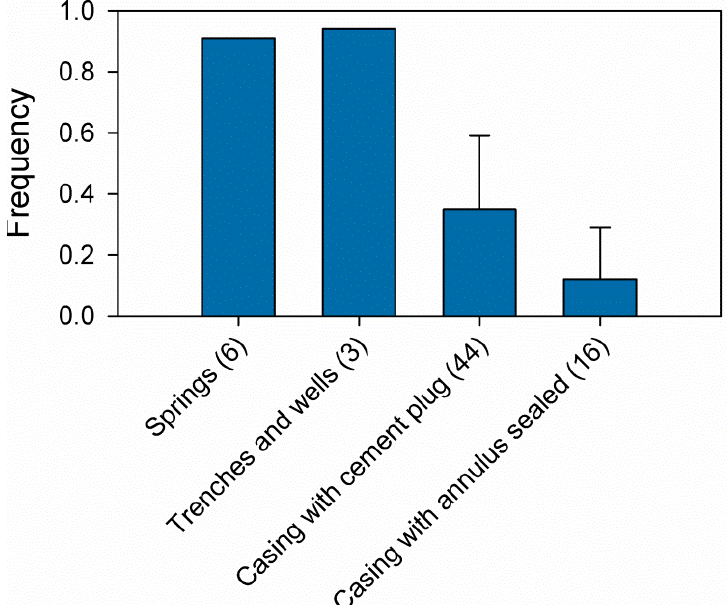
Figure 5. Frequency of coliform detection in relation to well construction. Sample size is given in